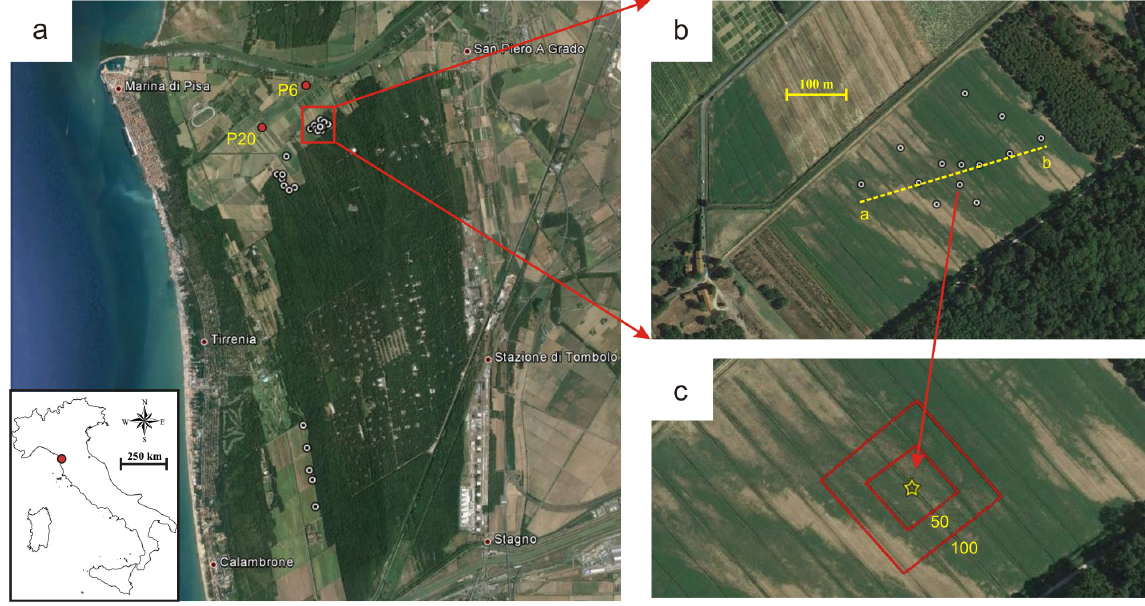
Figure 1. Location map of the Italian reference and calibration site for TEM method. (a) Red square delineates the area where the reference site is established. (b) Detailed map of the selected field area and (c) a zoom in to the reference coil position. The outer red boundaries mark the 50 × 50 m and 100 × 100 m loop respectively. Yellow dashed line shows the profile location illustrated in Figure 5. Red dots locate the P20 and P6 boreholes while the white dots indicate the position of the ground-based TEM soundings performed in the entire survey